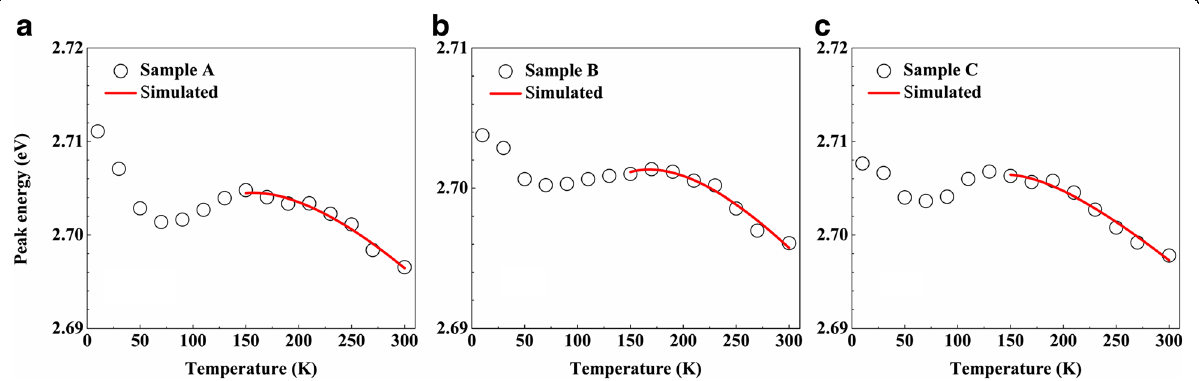
Fig. 4 Temperature-dependent PL peak energy of the a sample A, b sample B, and c sample C